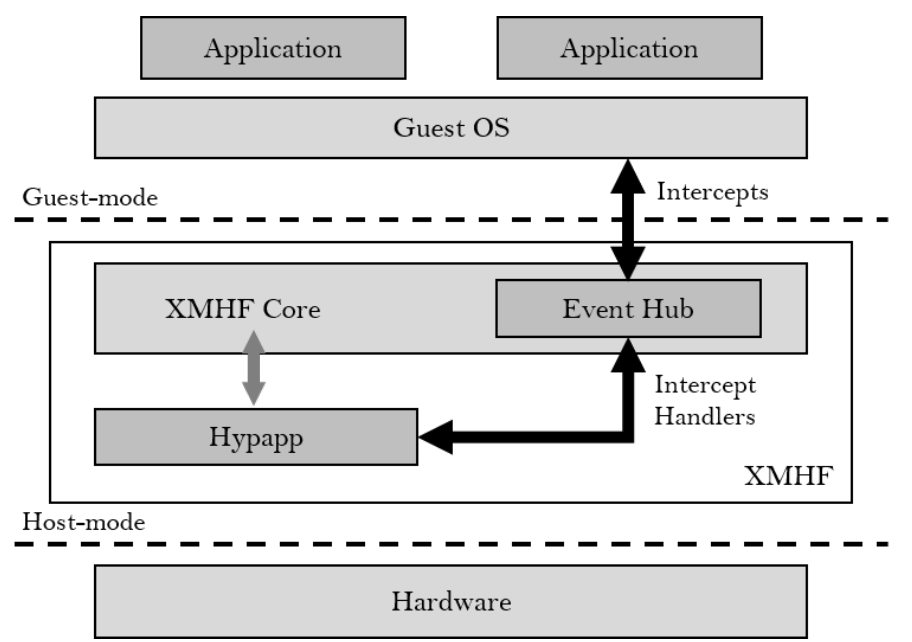
Figure 1. An Architecture of XMHF [5].